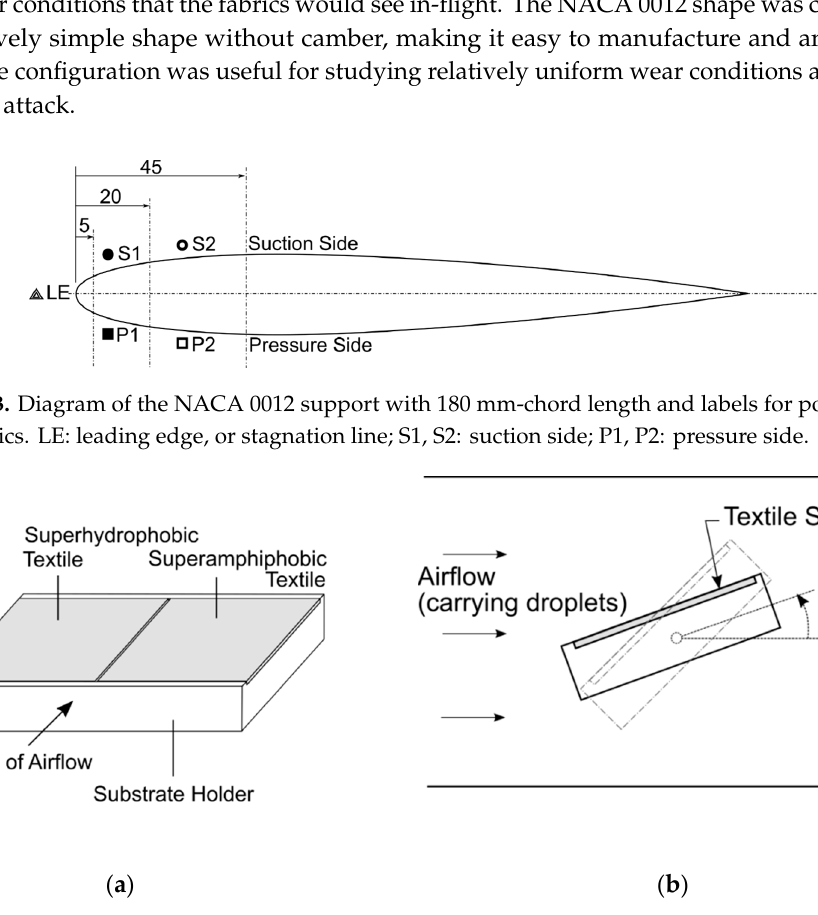
Figure 2. Icing wind tunnel.